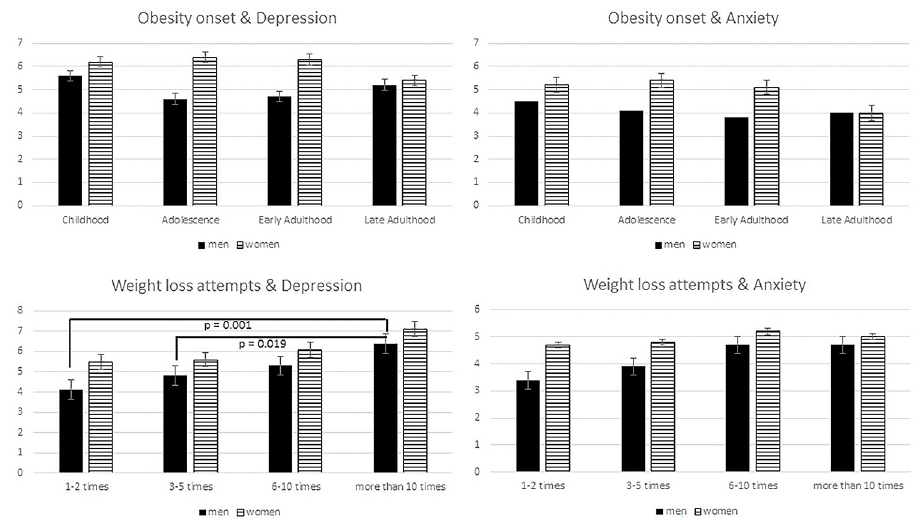
Fig 1. Onset of obesity and weight loss attempts associated with psychological health for male and female participants (for depression: Mean PHQ-9 score, for anxiety mean GAD-7 score).